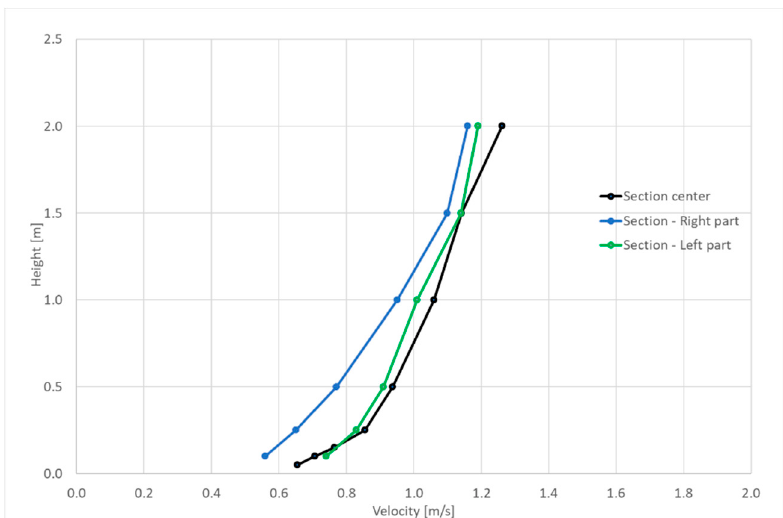
Figure 3. Velocity profile for medium-scale configuration.